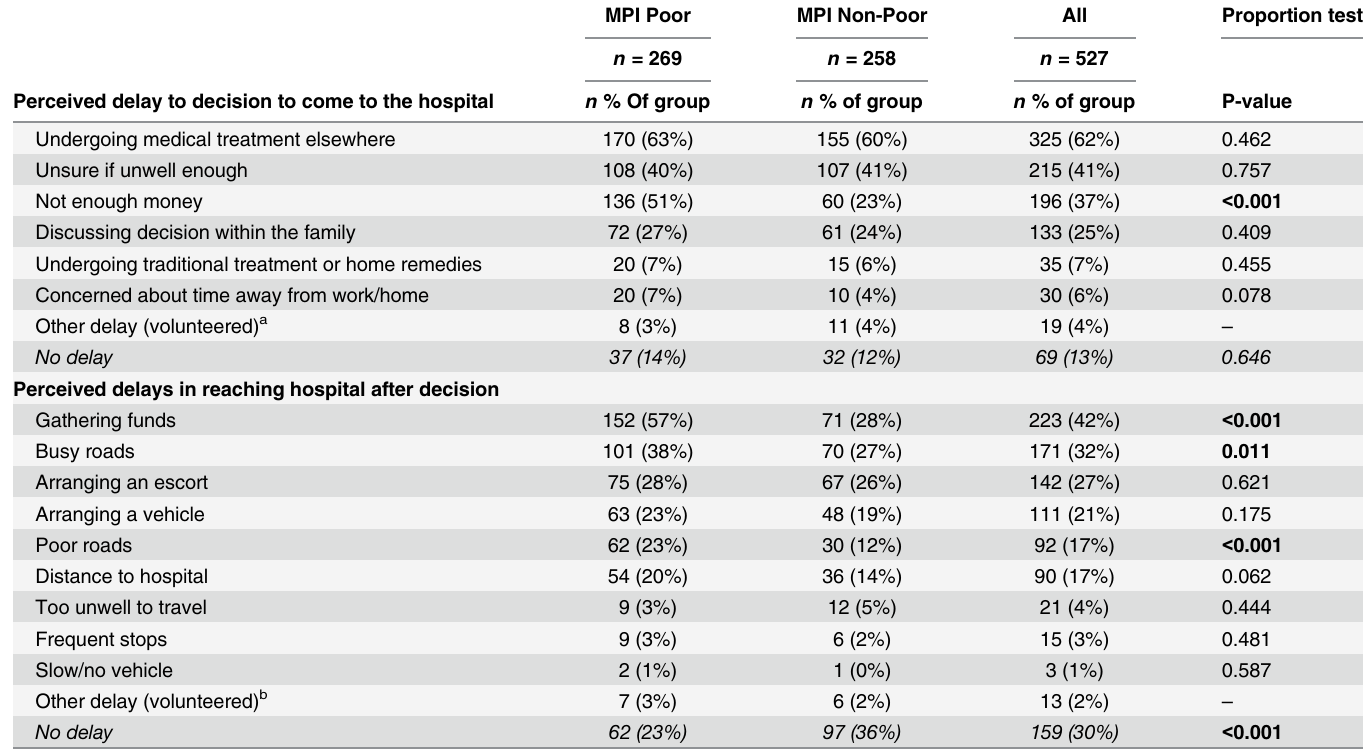
Table 6. Summary of perceived delays affecting the decision to attend referral hospital, and delays to transport after this decision. MPI Poor MPI Non-Poor All Proportion test n = 269 n = 258 n =